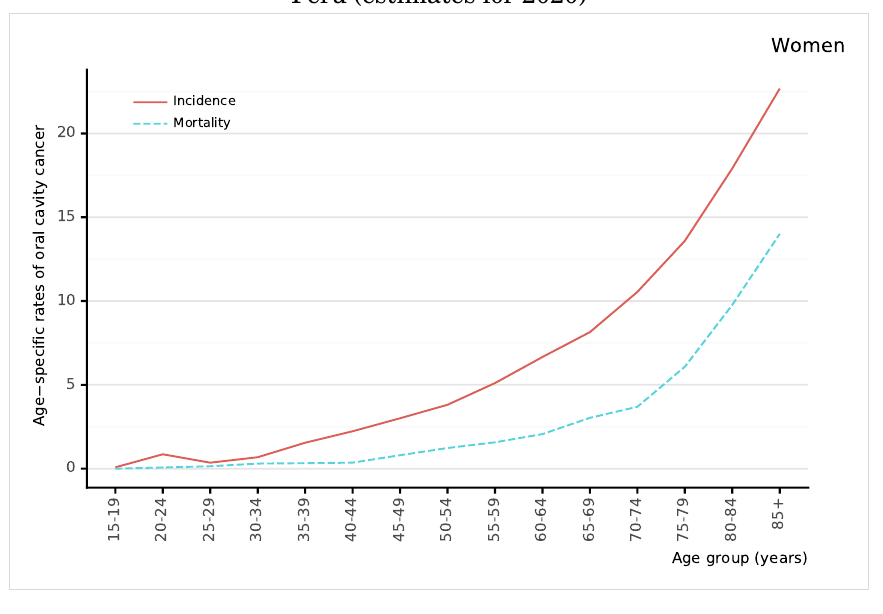
Figure 47: Comparison of age-specific oral cavity cancer incidence and mortality rates among women